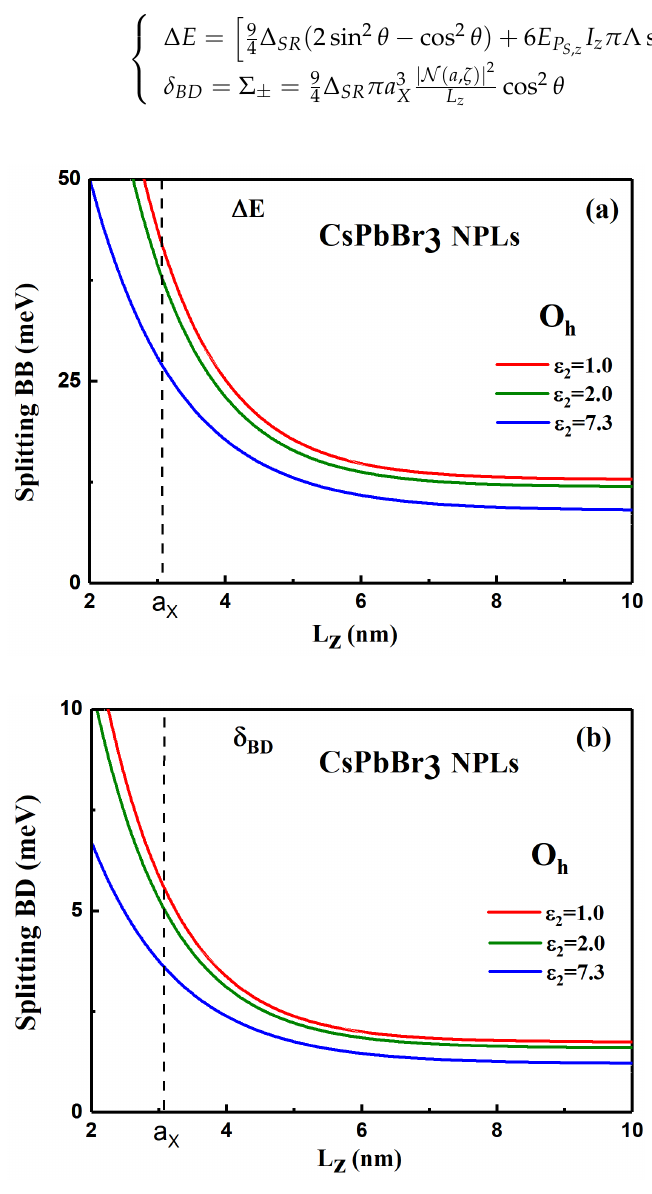
Figure 4. ( a ) Bright–bright splitting ∆ E and ( b ) bright–dark splitting δ BD , in CsPbBr 3 NPLs with a cubic symmetry and different dielectric mismatches (the outside dielectric constant ε 2 varying from 7.3 to 1). The vertical line indicates a size comparable to the exciton Bohr